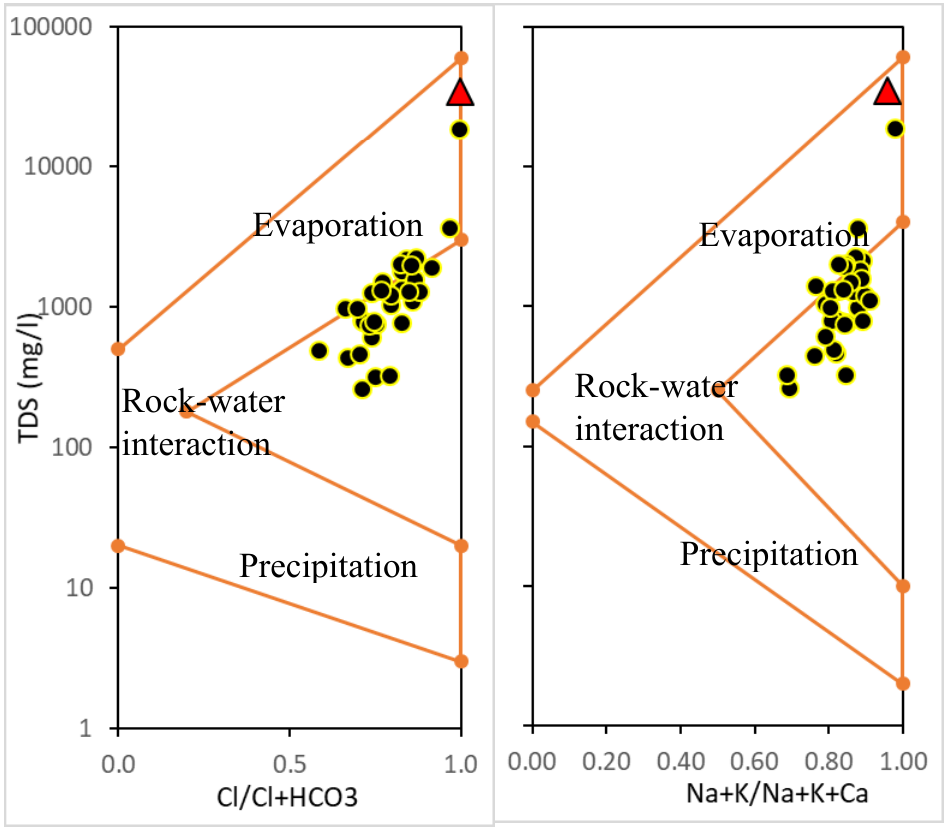
Figure 6. Gibb’s plots—Mechanism controlling water chemistry.